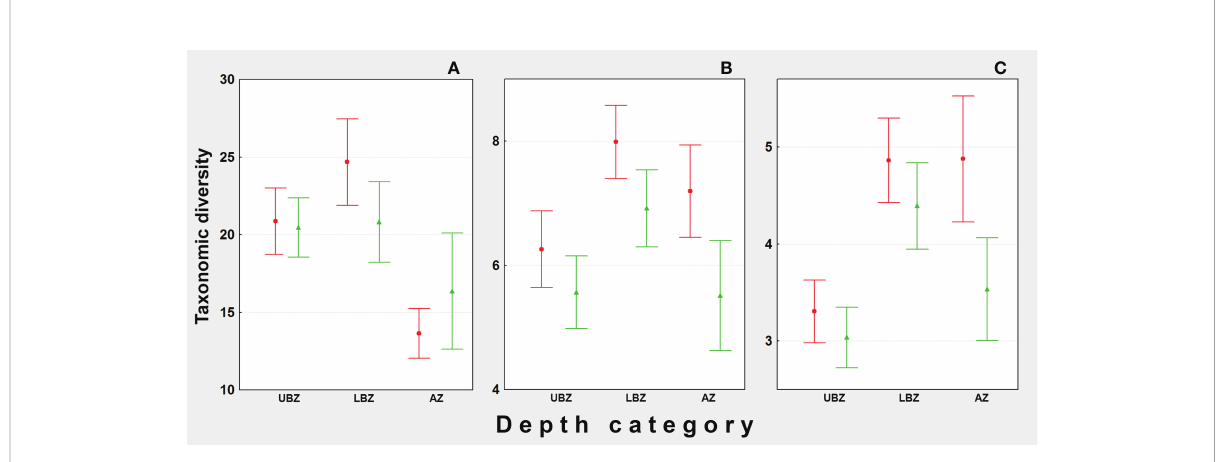
FIGURE 12 Punctual comparison (0.995 sample coverage) of taxonomic richness ( q = 0) (A) , Shannon diversity ( q = 1) (B) and Simpson diversity ( q = 2) (C) during SOGOM 3 (red) and SOGOM 4 (green). Upper bathyal zone (UBZ), lower bathyal zone (LBZ), abyssal zone